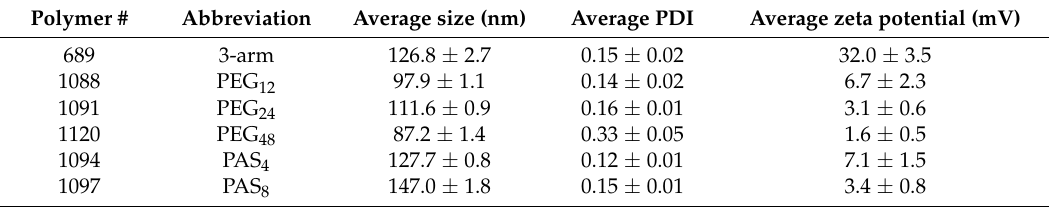
Table 2. Particle size (Z-average), polydispersity index (PDI), and zeta potential of plasmid DNA (pDNA) polyplexes formed in HEPES-buffered 5% glucose (HBG) buffer determined with dynamic laser-light scattering (DLS). Mean of three measurements of the same sample is indicated. Polymer at nitrogen-to-phosphate ratio (N/P) 12 and 2 µg plasmid DNA (pDNA) were separately diluted with HBG pH 7.4 to 30 µL each. Then solutions were mixed and incubated for 30 min. Polyplexes were diluted to 800 µL with 10 mM NaCl pH 7.4 prior to measurement. Particle size displayed as number mean can be found in Table S2. # indicates internal library compound IDs.